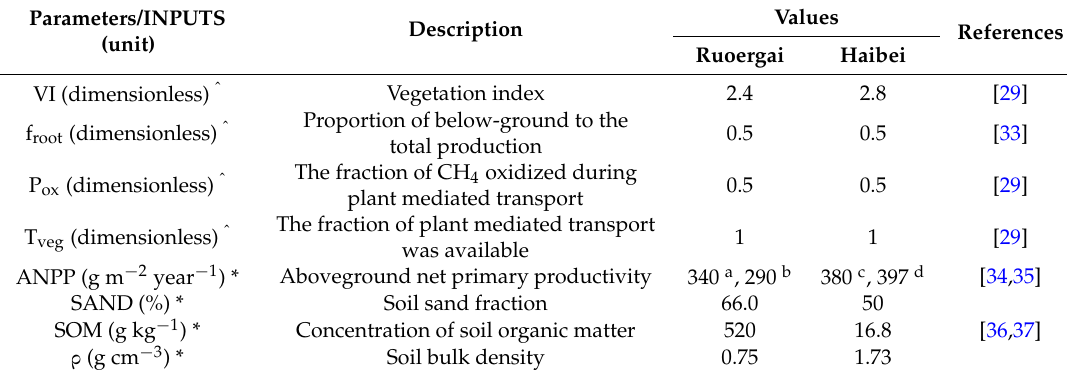
Table 1. Site-specific parameters and model inputs of CH4MOD wetland